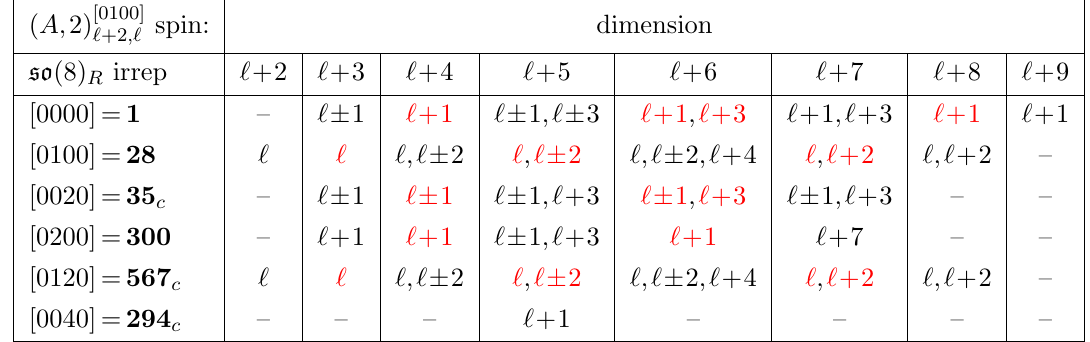
Table 26 . All possible conformal primaries in S 2 (cid:2) S 2 and S 3 (cid:2) S 3 corresponding to the ( A; 2) [0100] superconformal